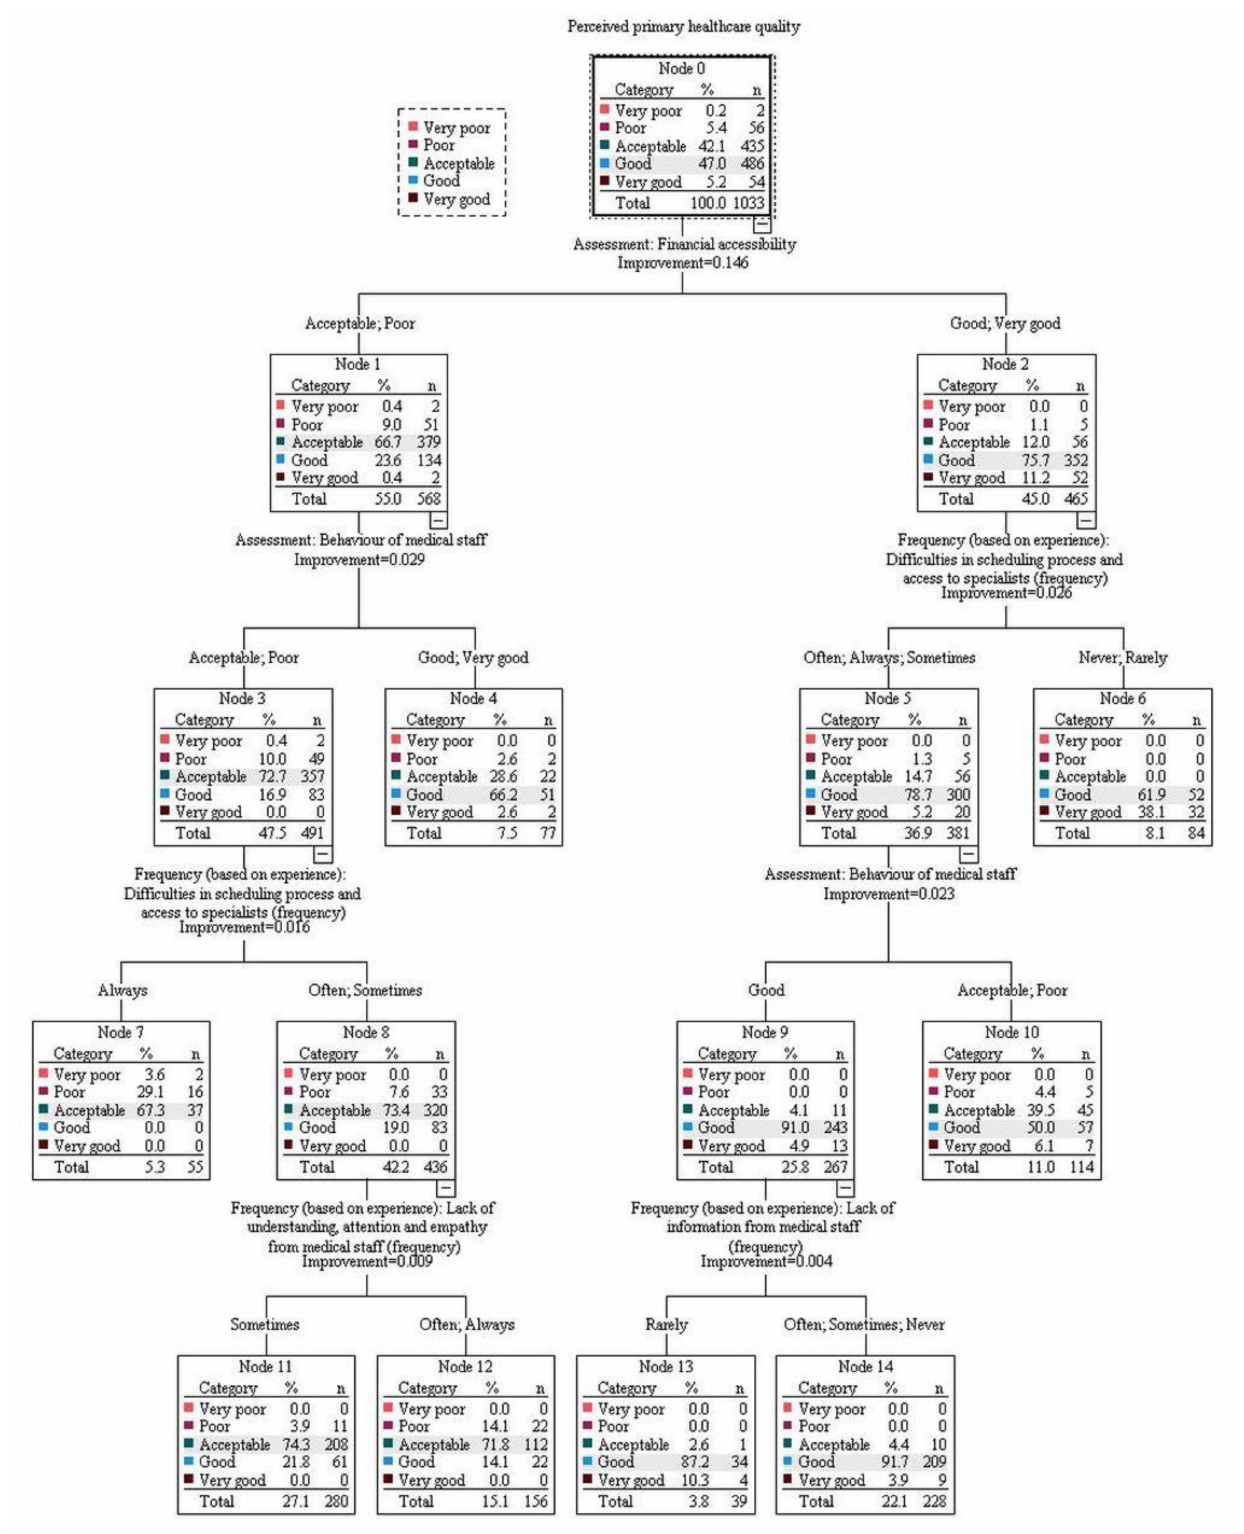
Figure A3. CRT model